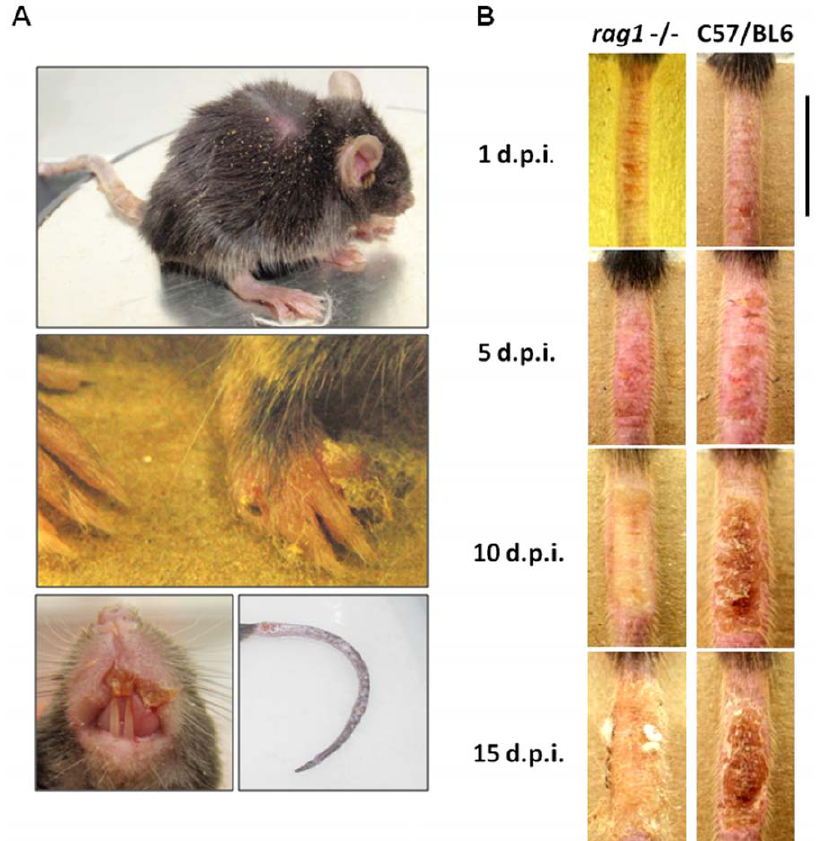
Figure 3. Clinical signs and lesion kinetic in T and B-cell deficient mice. Rag1 2 / 2 animals (n=6) were infected with 10 7 p.f.u. of VACV-WR by tail scarification. ( A ) Clinical signs of disseminated disease in Rag1 2 / 2 . Starting on the second week post-infection, Rag1 2 / 2 mice had signs of generalized disease, such as ruffled fur, arched back and disseminated lesions, primarily at the face, forepaw and tail. The animal shown is representative of the group. ( B ) Rag1 2 / 2 presented a delayed lesion healing compared to WT mice. Note the ulcerative, purulent nature of the lesion in Rag1 2 / 2 compared to the scab formed in C57BL/6 animals. Photos are representative of the groups indicated. Black bar represents 1 cm.